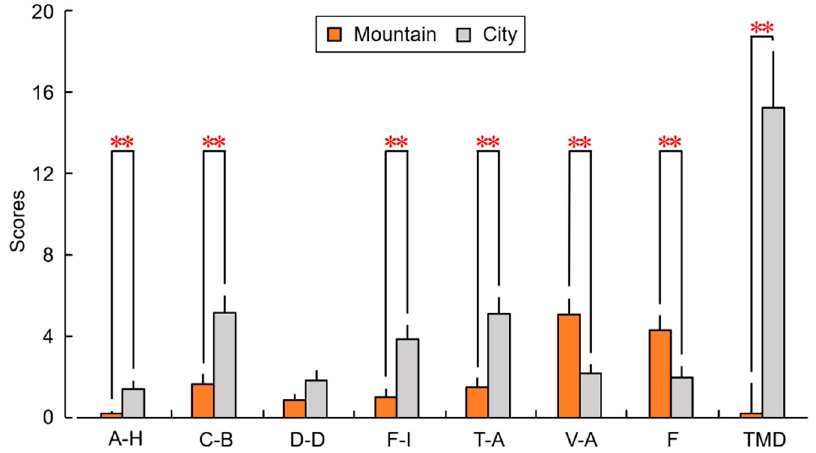
Figure 7. Psychological effects evaluated by POMS 2 after viewing the mountain and city images. ( n = 27, mean ± standard error, ** p < 0.01 [mountain vs. city], Wilcoxon signed-rank test). A–H,